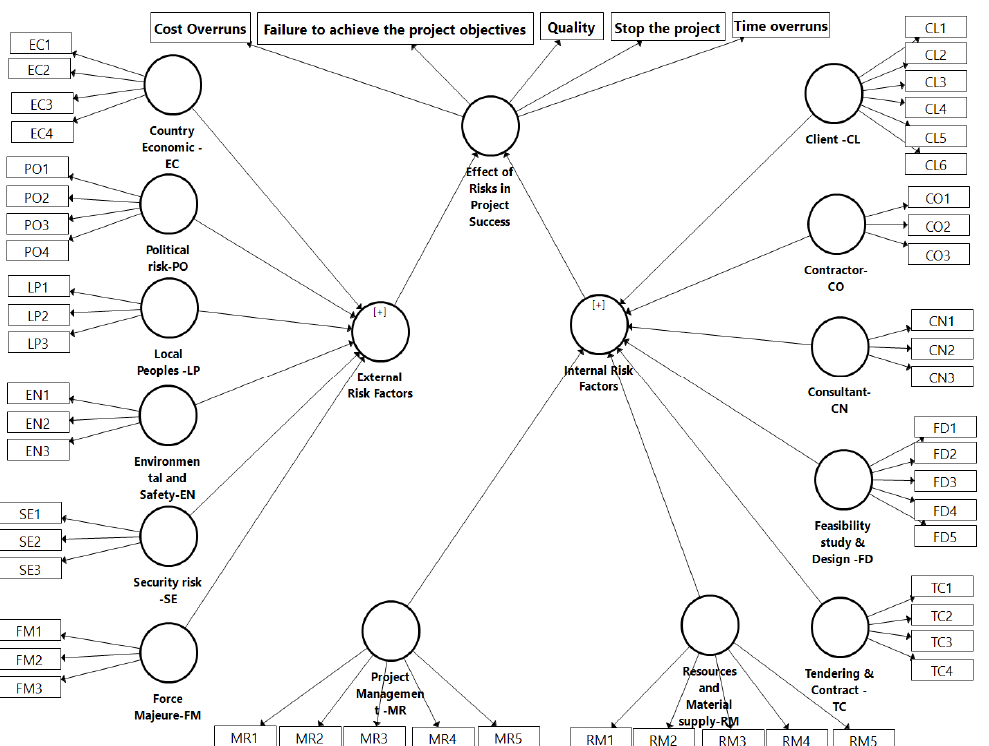
Figure 4. The Research Model (cause and effect of risk factors). Figure 4. The research model (cause and effect of risk factors).